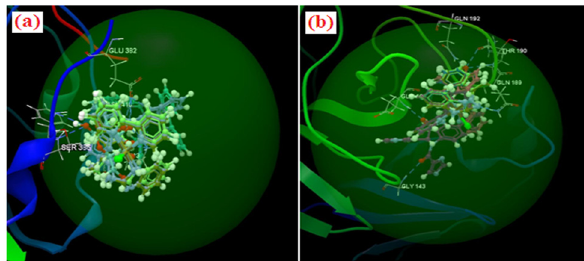
Figure 5. The co - crystallized X77 ( N -( 4 - tert - butylphenyl )- N -[( 1 R )- 2 -( cyclohexylamino )- 2 - oxo - 1 -( pyridin - 3 - yl ) ethyl ]- 1 H - imidazole - 4 - carboxamide ) was considered as a standard ligand to compare the docking results of the studied com - pounds. The docking studies revealed that the docking